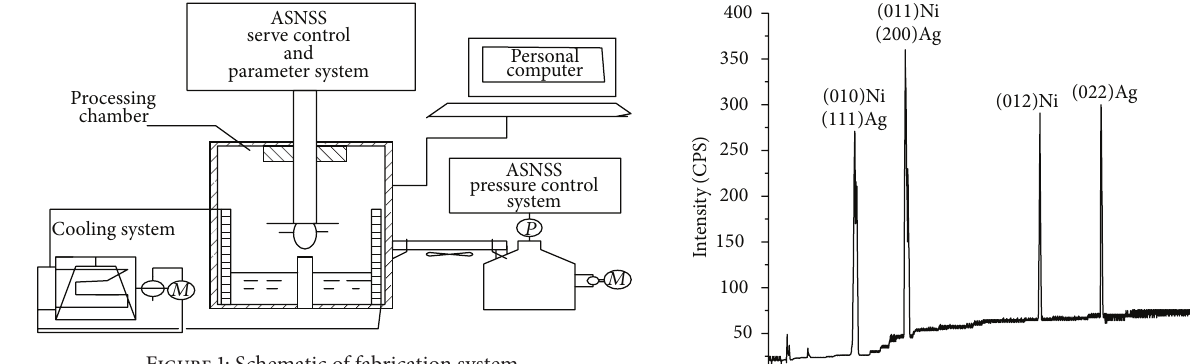
Figure 1: Schematic of fabrication system.